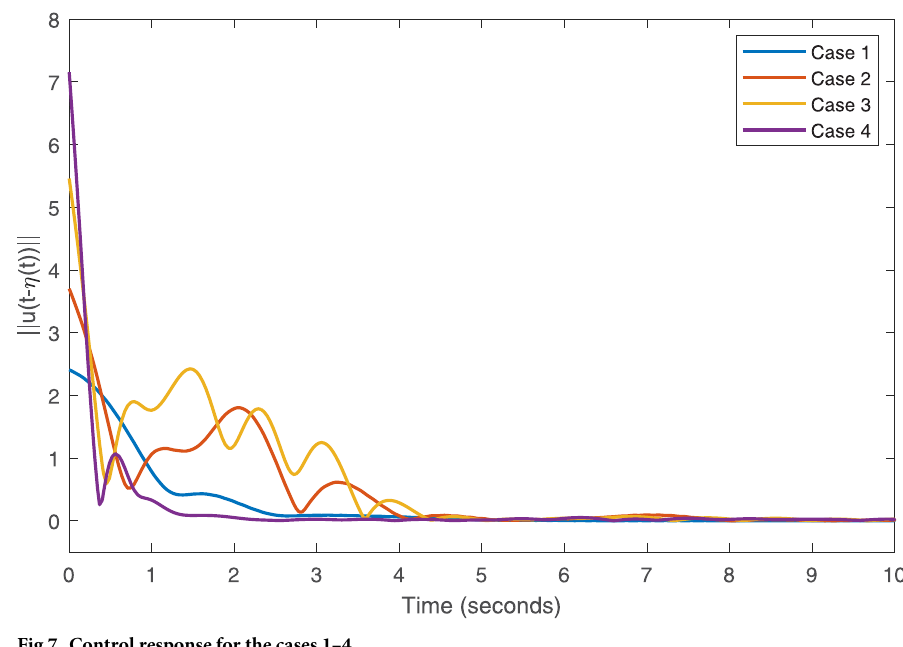
Fig 7. Control response for the cases